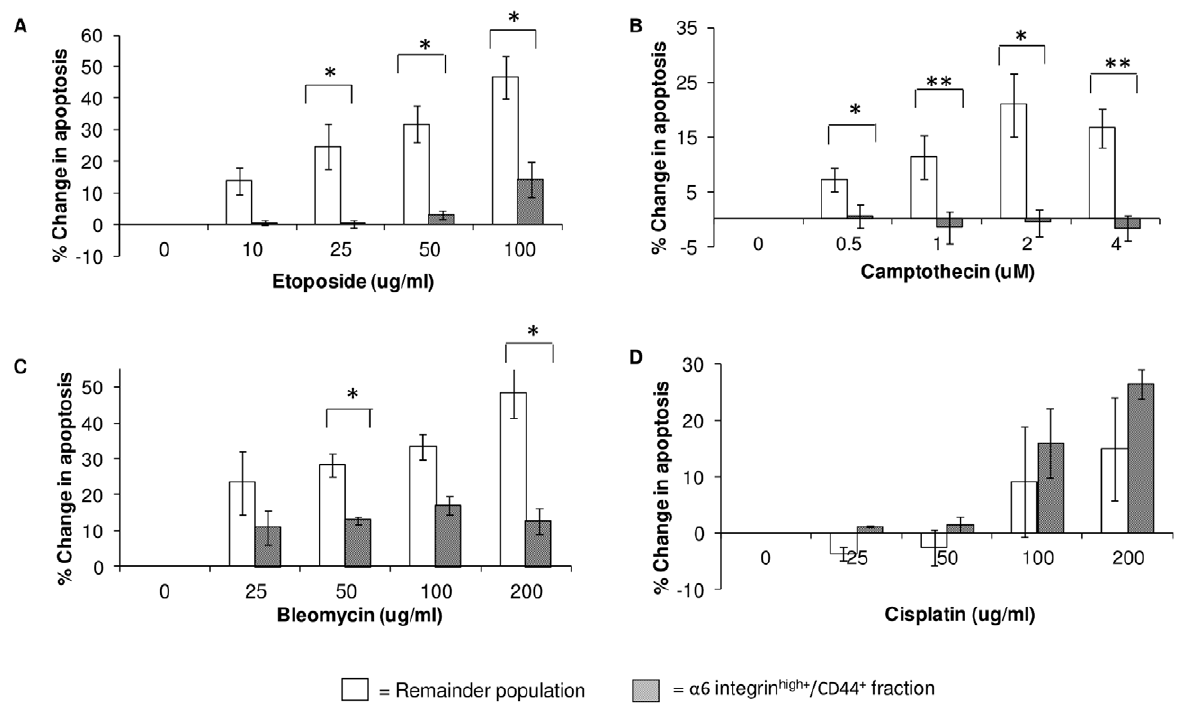
Figure 3. Drug-induced apoptosis. Keratinocytes at 50% confluency treated were with genotoxic agents at increasing doses and analysed for apoptotic cells using flow cytometry. Annexin-V + cells (DAPI + and DAPI 2 ) were totalled in both the a 6 integrin high + /CD44 + and remainder cell populations and plotted as a change in percentage from the control (vehicle only control that averaged , 10% apoptosis). Results show apoptosis levels 24 hours after treatment with Etoposide (A), Camptothecin (B) Bleomycin (C) and Cisplatin (D). Data represents the mean 6 SEM where n=3. Statistical significance was determined using the paired Student’s t -test **P , 0.01, *P , 0.05.